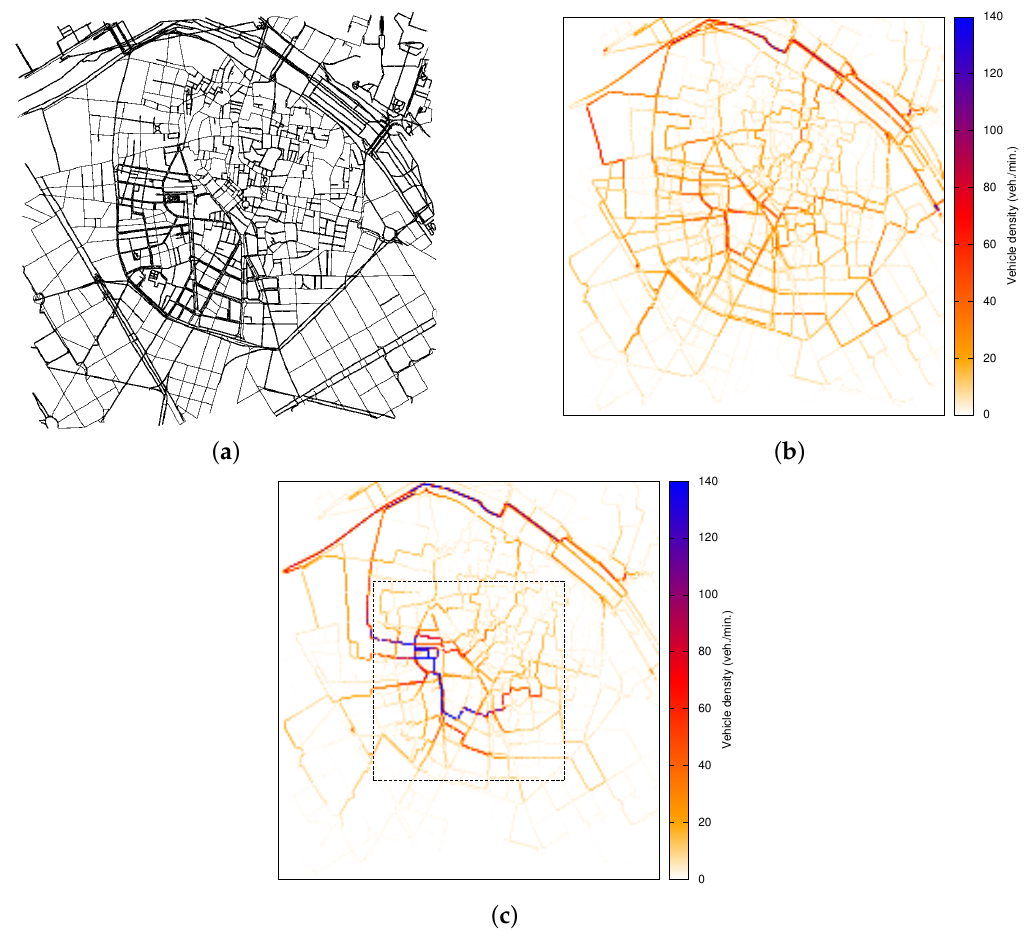
Figure 5. Scenario 2: City of Valencia, Spain. ( a ) Street map layout; ( b ) Krauss model: vehicular density for each street; ( c ) Downtown model: vehicular density for each street in the downtown (square